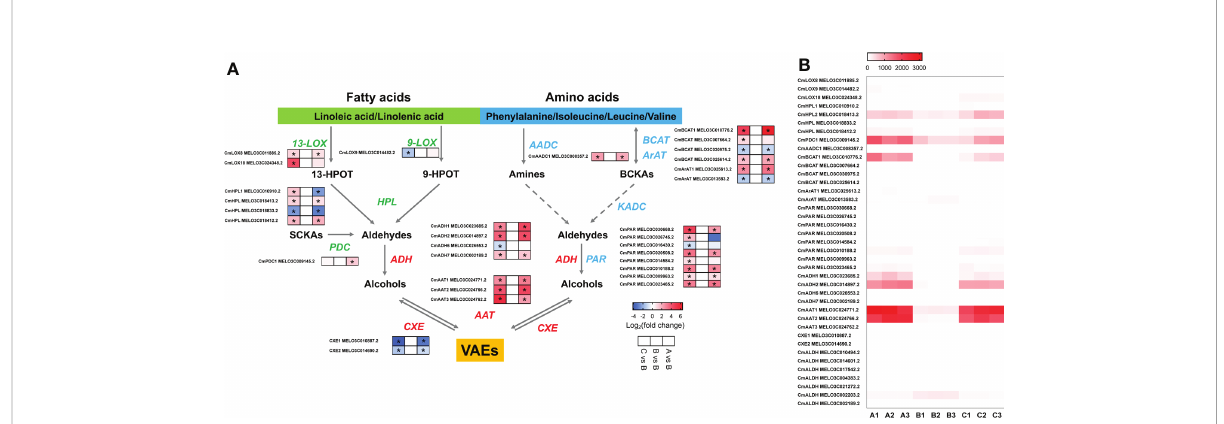
FIGURE 4 The analysis of differentially expressed genes in VAE biosynthesis pathway. (A) VAE biosynthesis in fatty acid and amino acid pathways. (B) A heatmap of DEGs involved in these pathways. Values of log2(foldchange) and FPKM are used in the heatmap of A and B, respectively. 13-HPOT, 13( S )-hydroperoxy-9( Z ),11( E ),15( Z )-octadecatrienoic acid; 9-HPOT, 9( S )-hydroperoxy-10( E ),12( Z ),15( Z )-octadecatrienoic acid; SCKAs, straight- chain ketoacids; BCKAs, branched-chain ketoacids; LOX, lipoxygenase; HPL, hydroperoxide lyase; PDC, pyruvate decarboxylase;